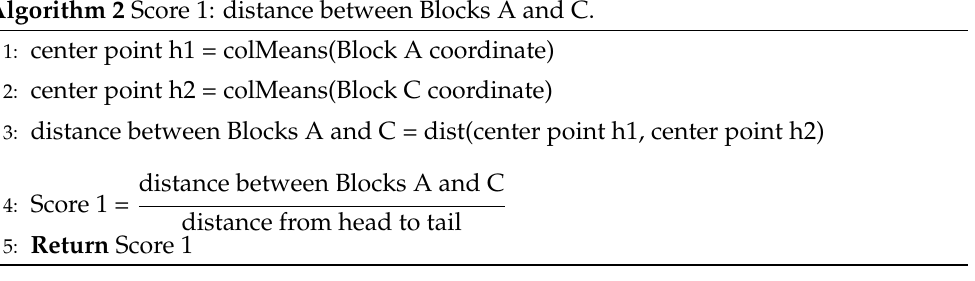
Figure 12. The distance between the hydrophilic clusters (Score 1). Blue dots represent length of the molecule. The red dot represents the center point of Block A. The green dot represents the center point of Block C. Algorithm 2 Score 1: distance between Blocks A and C.